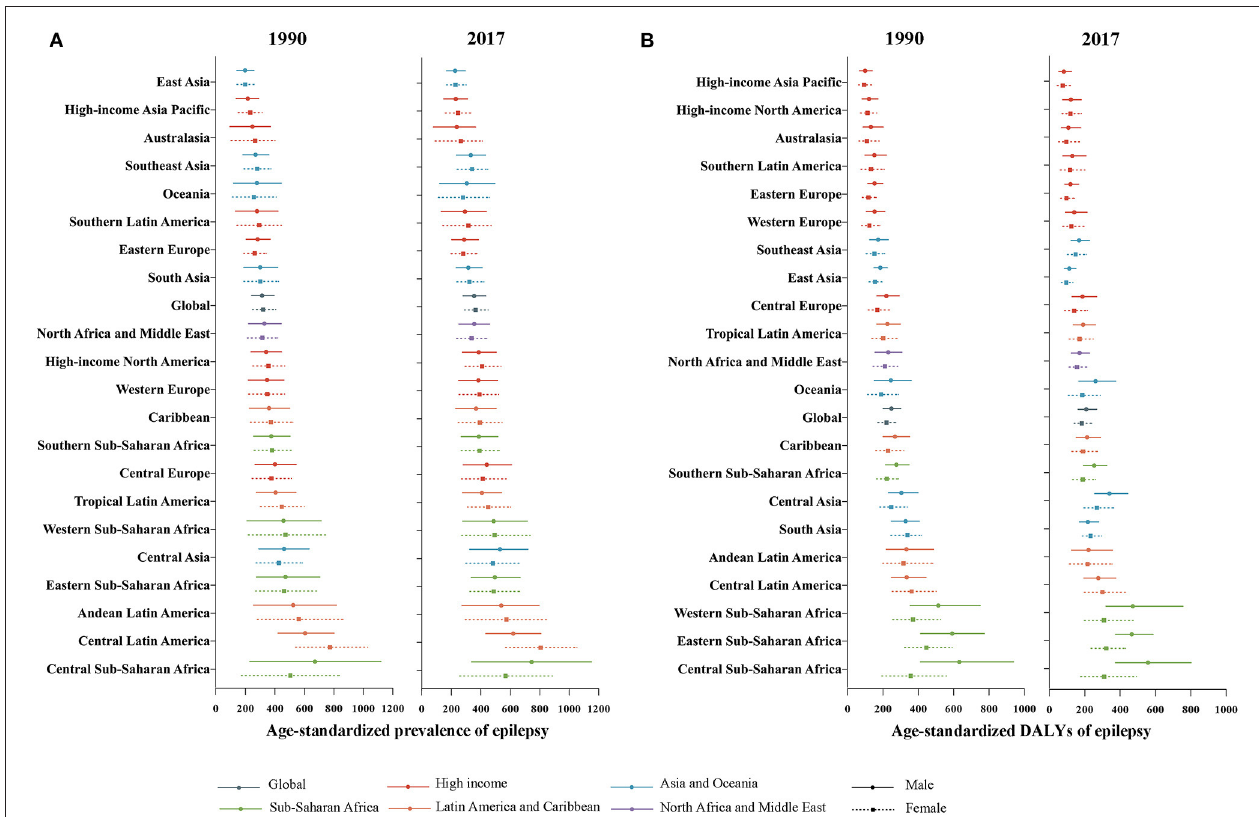
FIGURE 2 | Global gender-specific burden of epilepsy by 21 GBD regions in 1990 and 2017. (A) Age-standardized prevalence rate. (B) Age-standardized DALYs rate. The Y -axis order is arranged according to the level of the age-standardized prevalence and DALYs rate of males. DALYs, disability-adjusted